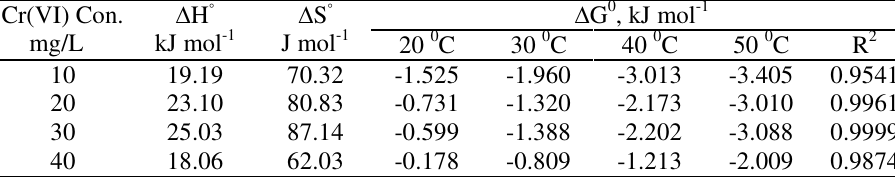
]Figure 3. Plot of Van't Hoff equation for the adsorption of Cr(VI) onto FMPGP. Table 3. Thermodynamic parameters for the adsorption of Cr(VI) onto